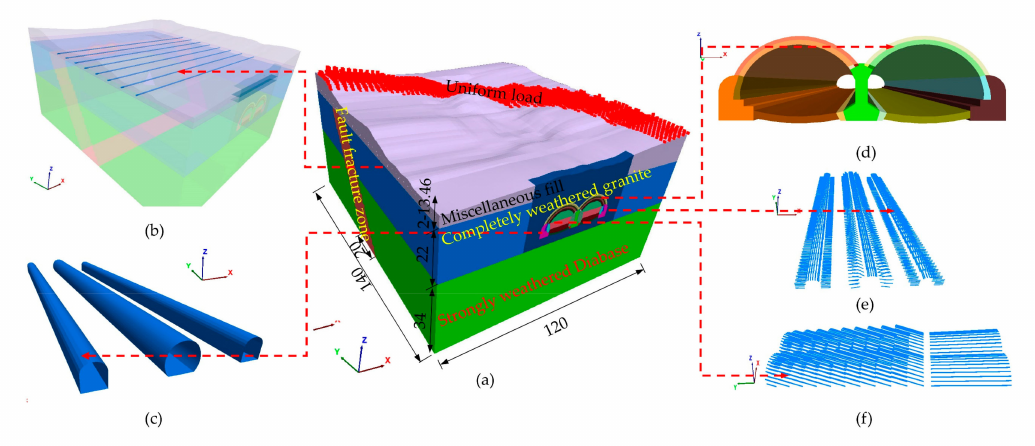
Figure 2. Numerical calculation model: ( a ) Double-arch tunnel model (unit: m); ( b ) Underground pipeline model; ( c ) The lining of the three pilot tunnels; ( d ) The lining and partition wall of the main tunnel; ( e ) The anchor bolts and advanced small conduits of the pilot tunnel; and ( f ) The long pipe shed.